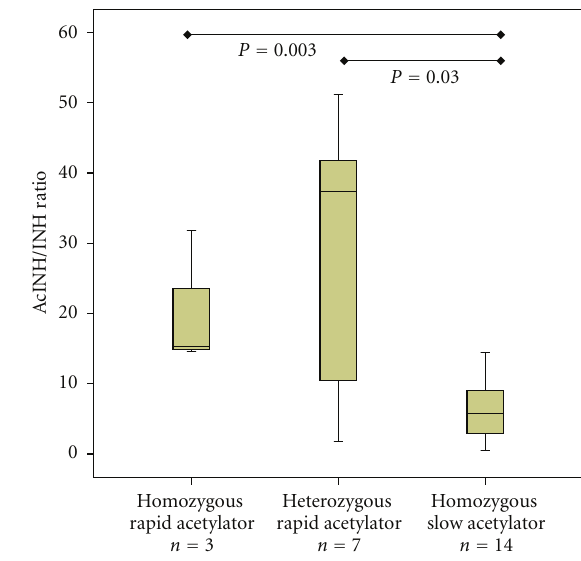
Figure 4: Correlation of isoniazid concentrations and body weight (regression line inserted).